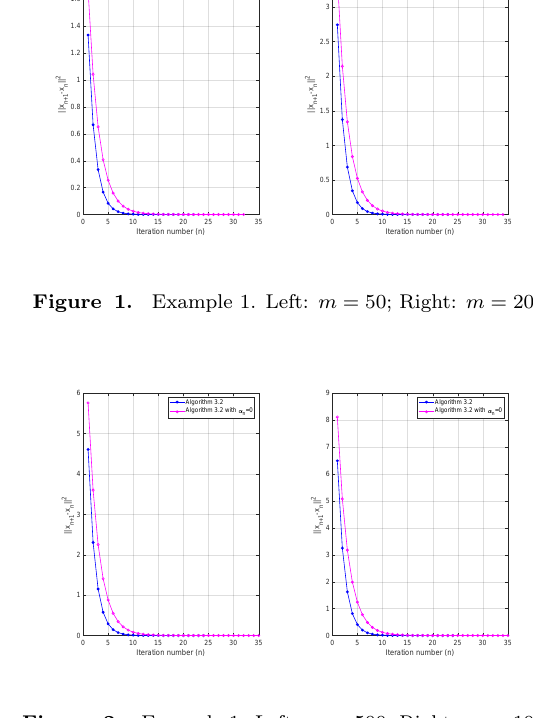
Algorithm 3.2 Algorithm 3.2 with